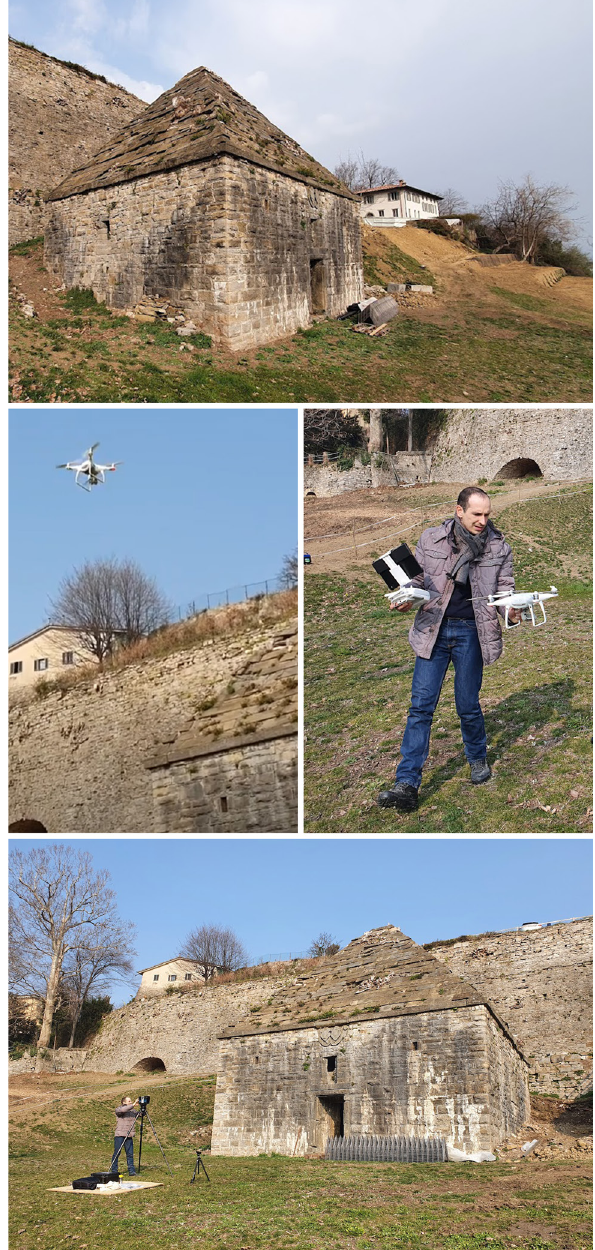
Figure 2. Torresino da Polvere of San Marco in